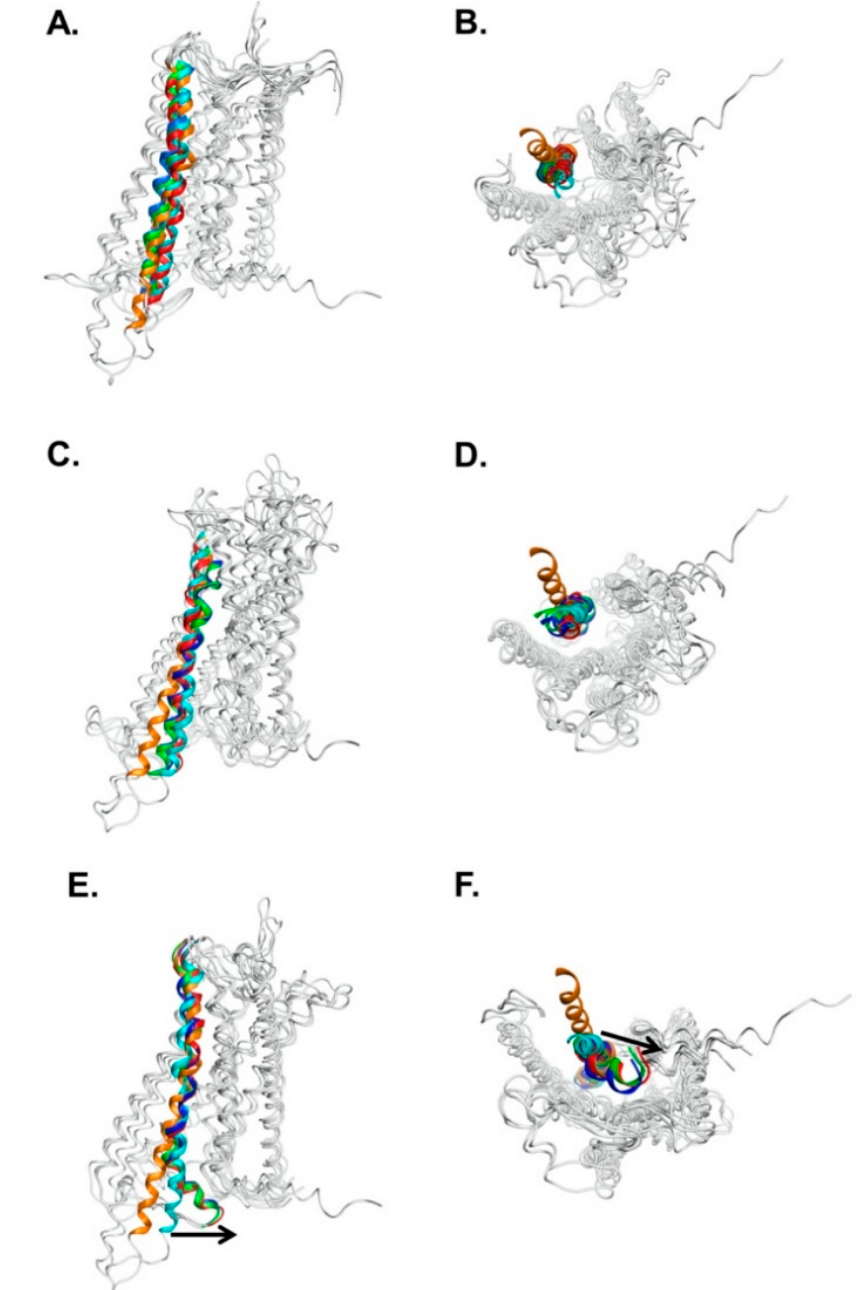
Figure 3. Superposition of structures at different simulation time frames for different AVPR2 systems. ( A , B ) Wild-type receptor AVPR2-WT; ( C , D ) Partial active mutant receptor AVPR2-D136A; ( E , F ) Inactive deletion-mutant AVPR2- ∆ V279. ( A , C , E ) are side views, and ( B , D , F ) are bottom views. For clarity, only transmembrane helix 6 (TM6) at different time frames is colored, while other regions are shown in gray. Structures in cyan, red, green, and blue indicate the TM6 in the receptor structures at initial time, 500, 1000, and 1500 ns in the MD simulations, respectively; that in orange is TM6 in putative activated form of AVPR2. In AVPR2-WT and AVPR2-D136A, TM6 was tilted slightly outward. However, in AVPR2- ∆ V279, the intracellular part of TM6 was shifted inwards, obstructing the G-protein binding site. The arrows indicate the inward movement of TM6.